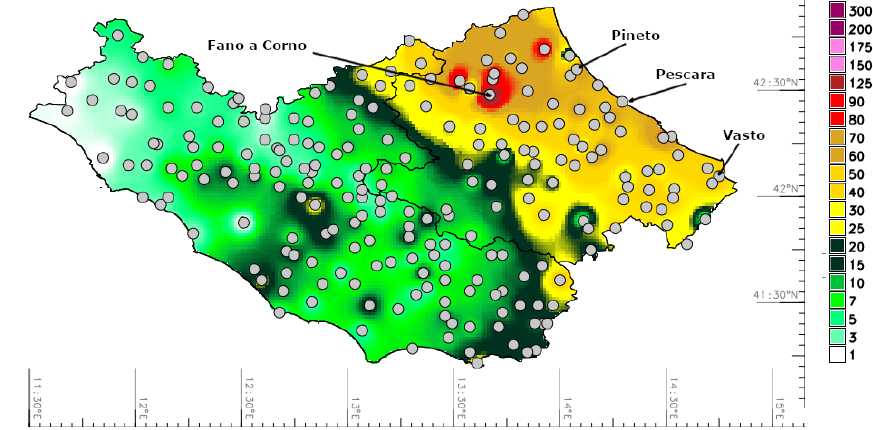
Figure 3. Observed daily precipitation (mm) on 3 May 2018 in the Lazio Abruzzo regions. The points represent the locations of rain gauges. Data courtesy of Italian Civil Protection